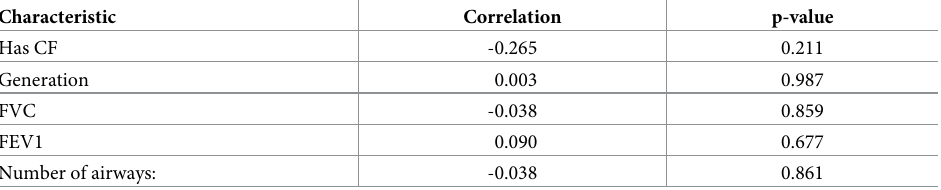
Table 4. Spearman correlation between the crowd quality (measured by the crowd-expert correlation of the inner airway) and five subject characteristics.